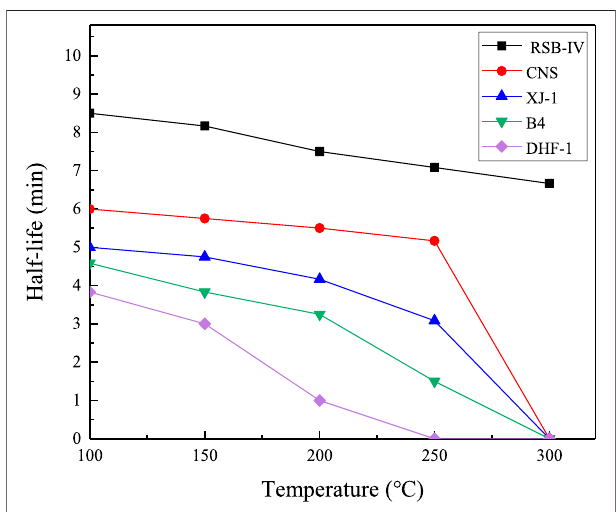
FIGURE 5 | Variation of half-life with temperature (Concentration was 0.5